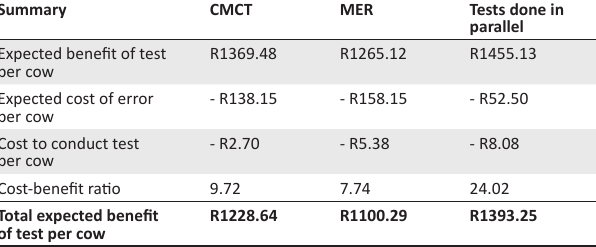
TABLE 2: Summary of the cost-benefit model showing expected costs and benefits and the cost-benefit ratio of the CMCT and MER test done separately and in parallel, taking cost of test per cow into